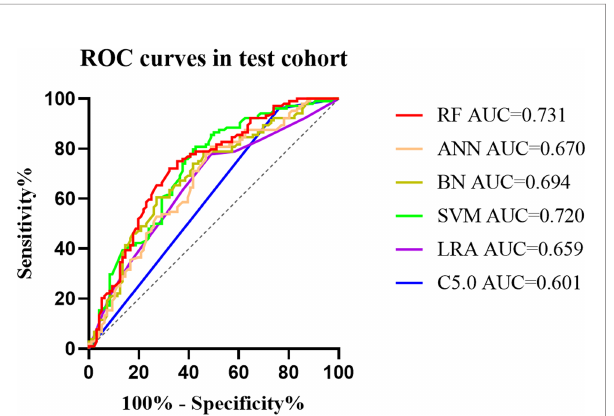
FIGURE 2 | The mixed ROC curves of the six machine learning models in the test cohort. The RF algorithm had the highest AUC, indicating that it was the tremendous signi fi cance for the differentiation of CLNM and non-CLNM in patients with PTC. ROC, receiver operating characteristic; AUC, the area under the curve; C5.0, decision tree C5.0 algorithm; LRA, logistic regression analysis; SVM, support vector machine; BN, Bayesian network; ANN, arti fi cial neural network; RF, random forest; CLNM, central cervical lymph node metastasis; PTC, papillary thyroid carcinoma.